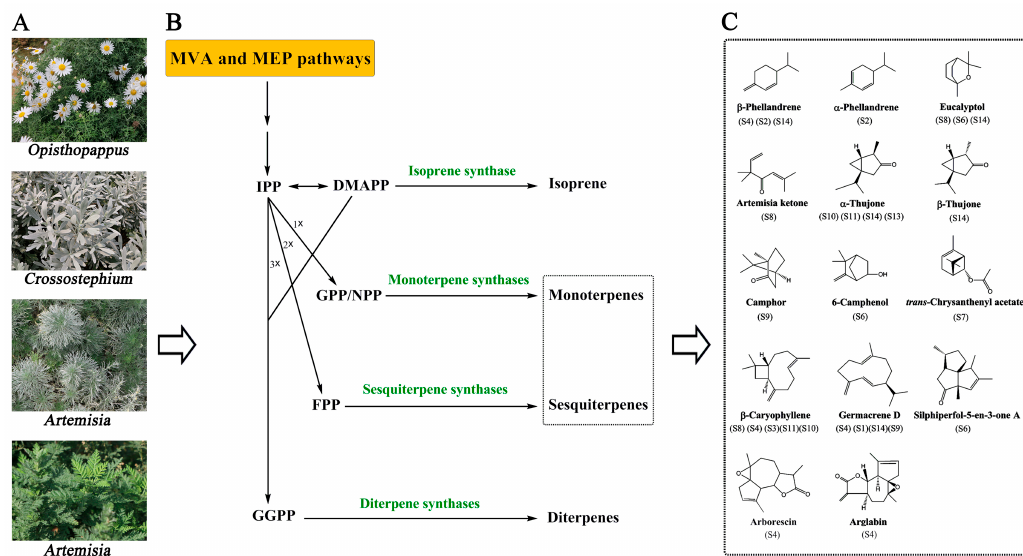
Figure 6. Local diagram of the terpenoid biosynthetic parthway and the chemical structures of the main compounds found in 14 Compositae plants. Graph ( A ) displays the representative samples used in this research; Graph ( B ) was modified according to the literature [37]; and ( C ) the sample numbers which are the same as in Table 2, denote the samples with the highest concentrations of constituents (above 100 ng/g FW).